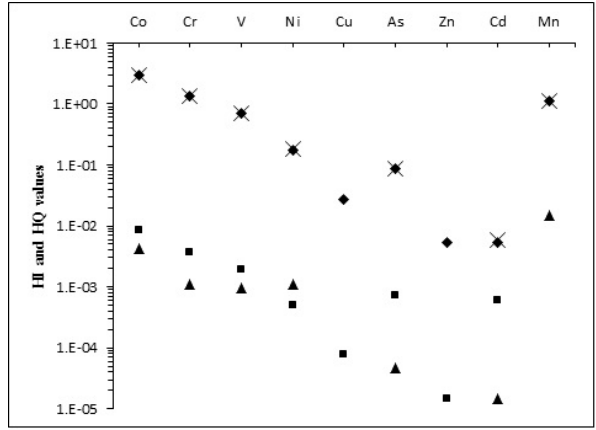
Figure 3. HIs and HQs for potentially toxic elements from Santiago Island. Symbols: His: crosses; HQs for ingestion: diamonds; HQs for dermal contact: squares; HQs for inhalation: triangles.